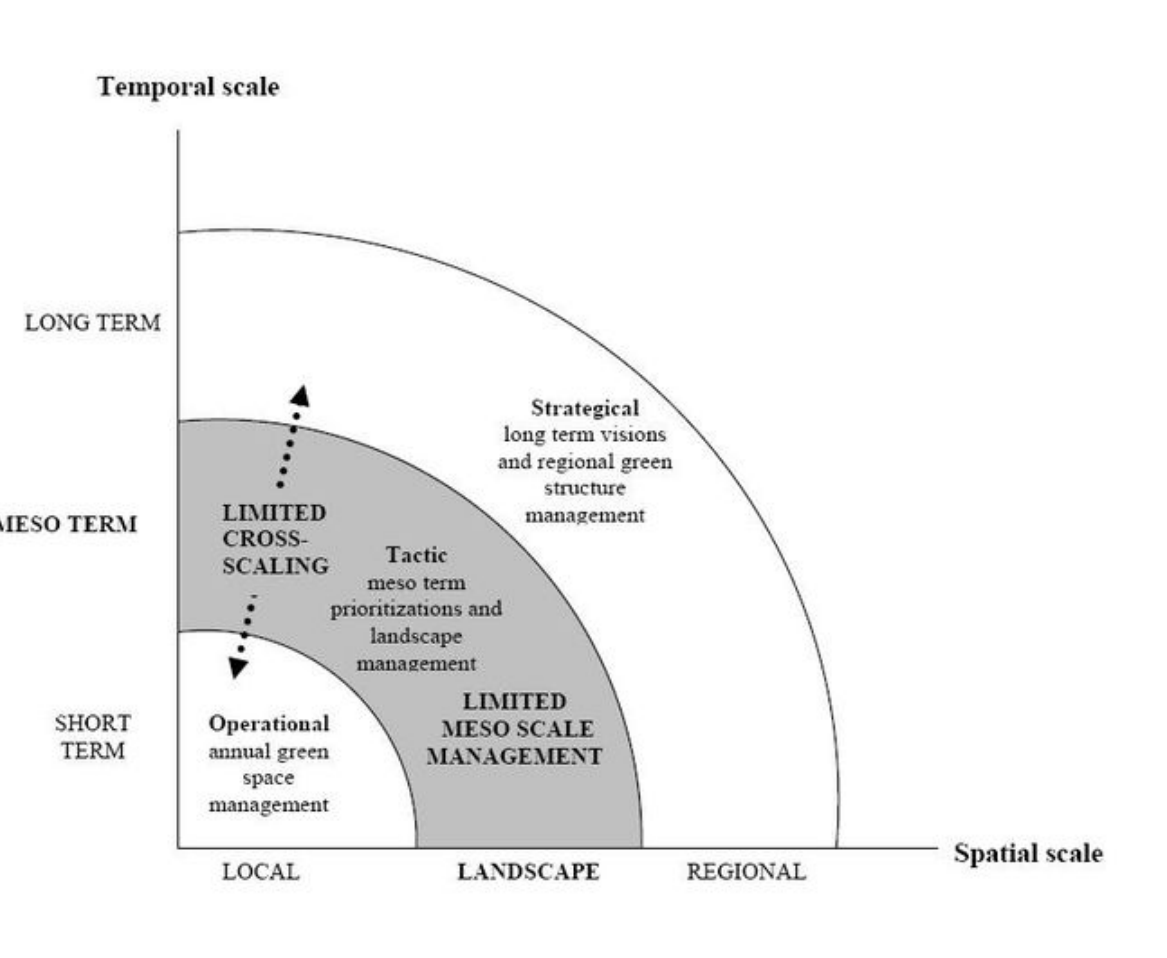
Fig. 2. The main deficits in scale management of green spaces in the GSMA are neglect of meso-scales and limited recognition of cross-scale